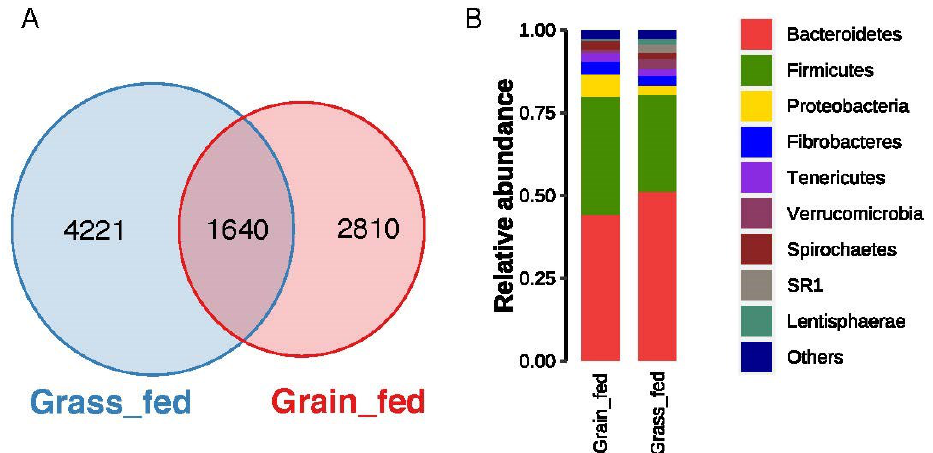
Figure 1. ( A ) Venn diagram of the number of OTUs identified between grass-fed and grain-fed rumen microbiome. ( B ) Stacked bar plot of the relative abundance of rumen bacterial communities at a phylum level between grass-fed and grain-fed